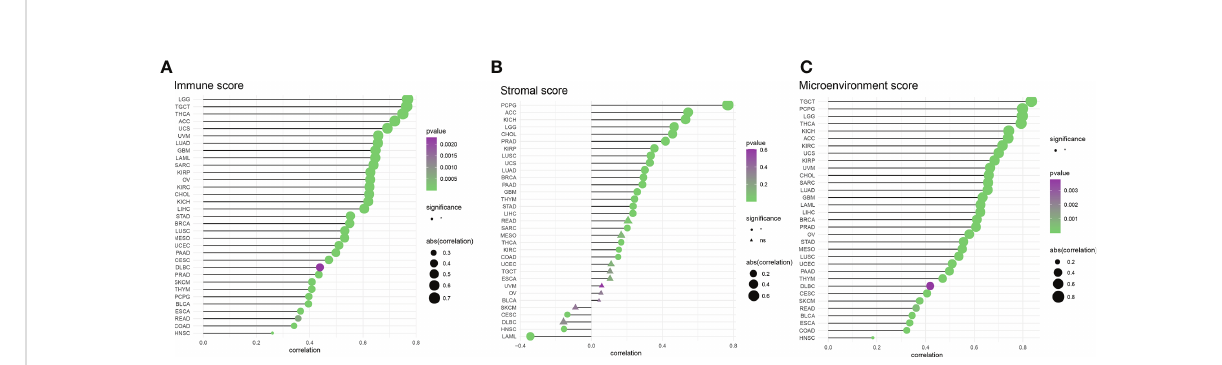
FIGURE 10 Correlation of AIM2 in fl ammasomes scores with tumor purity (A) Correlation of AIM2 in fl ammasomes scores with tumor Immune Score (Spearman ’ s correlation test). (B) Correlation of AIM2 in fl ammasomes scores with tumor Stromal Score (Spearman ’ s correlation test). (C) Correlation of AIM2 in fl ammasomes scores with tumor Microenvironment Score (Spearman ’ s correlation test) (all P <